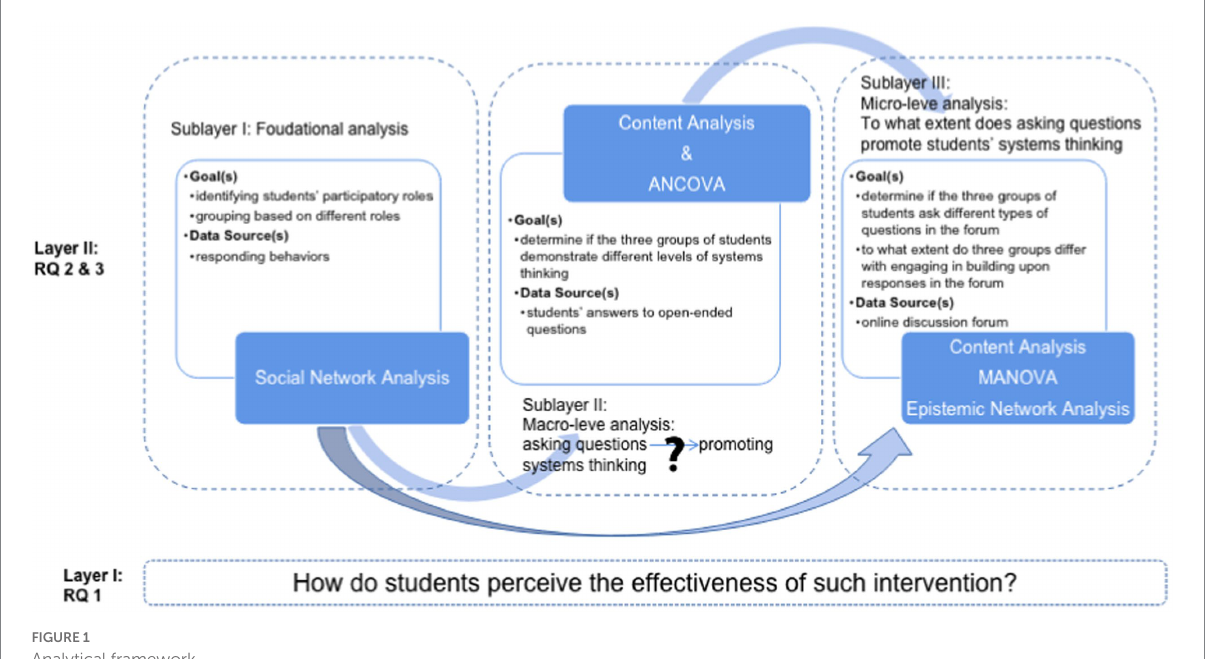
FIGURE 1 Analytical